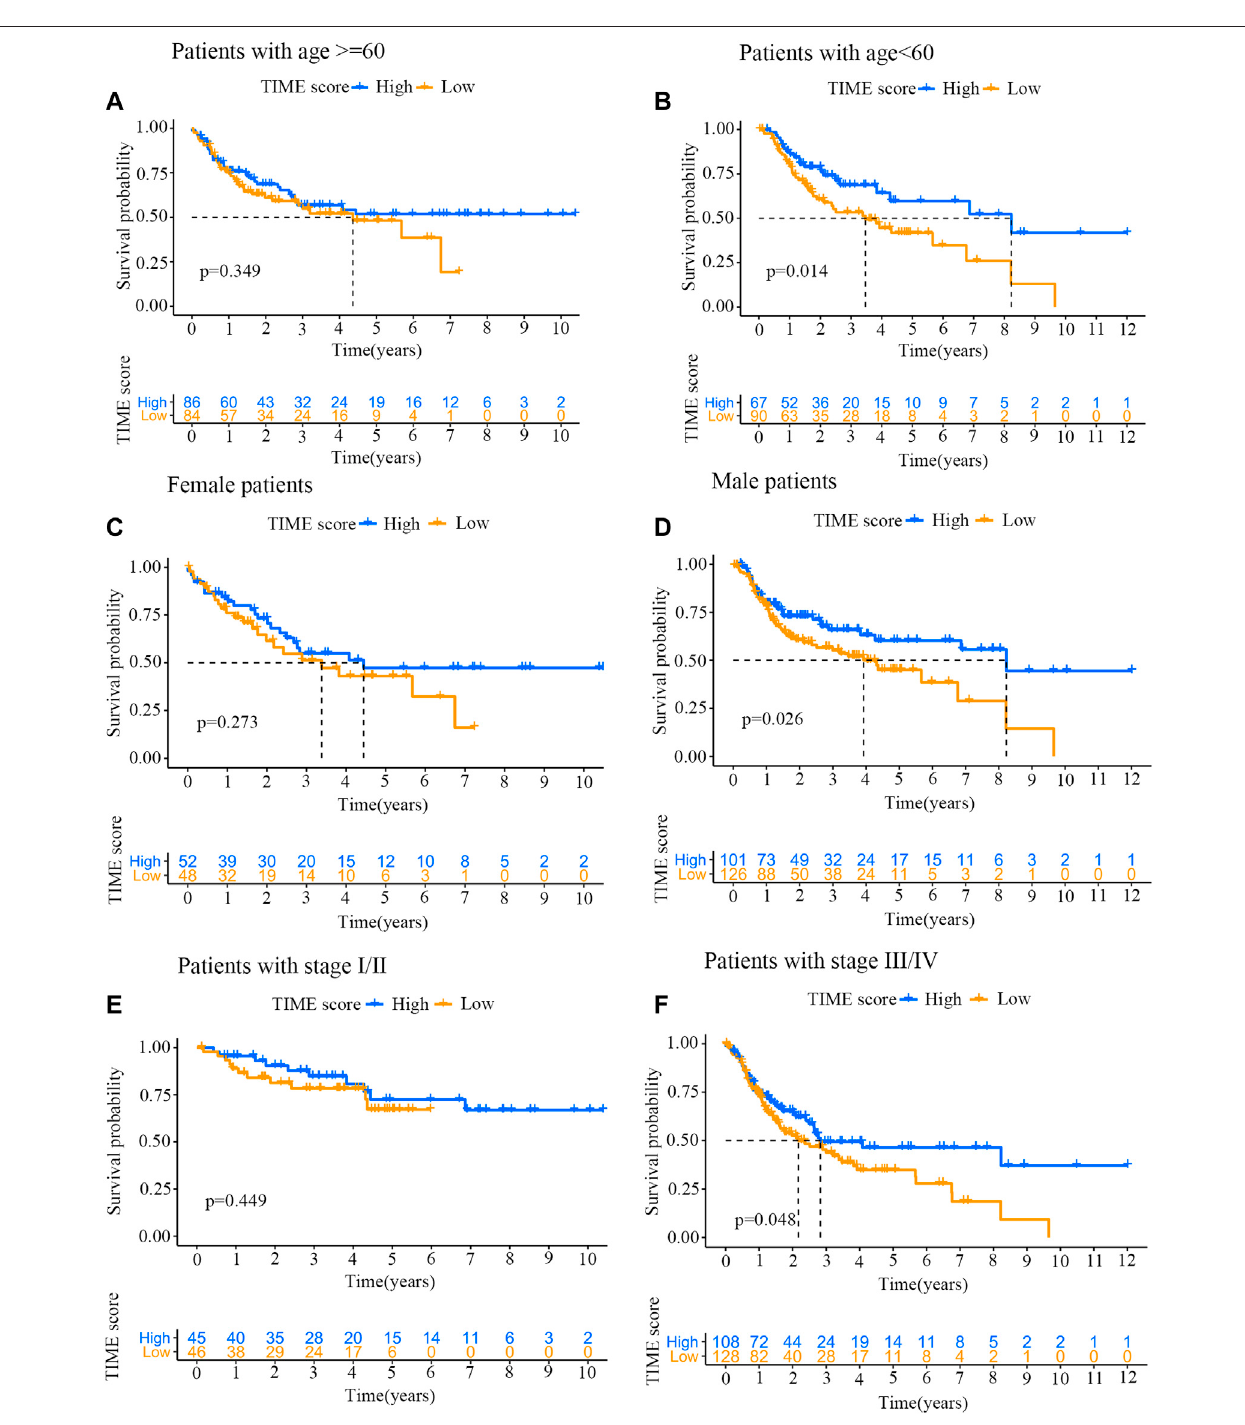
FIGURE5| PrognosisanalysisofhighandlowTIMEscoregroupswithspeci fi cclinicalcharacteristics. (A) Survivalcurvesforpatients(age ≥ 60 yearsold)fromhigh andlowTIMEscoregroups.Log-ranktest, p =0.349. (B) Survivalcurvesforpatients(age < 60 yearsold)fromhighandlowTIMEscoregroups.Log-ranktest, p =0.014. (C) SurvivalcurvesforfemalepatientsfromhighandlowTIMEscoregroups.Log-ranktest, p =0.273. (D) SurvivalcurvesformalepatientsfromhighandlowTIMEscore groups. Log-rank test, p = 0.026. (E) Survival curves for stage I/II patients from high and low TIME score groups. Log-rank test, p = 0.449. (F) Survival curves for stage III/IV patients from high and low TIME score groups. Log-rank test, p = 0.048.